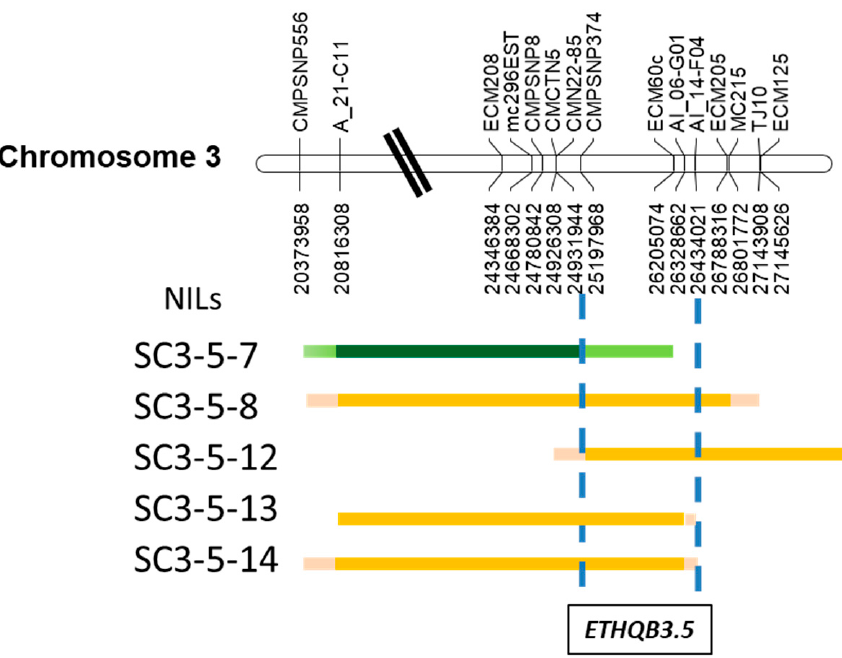
Figure 2. Ideogram showing the extent of the SC introgression on chromosome 3 among the Near- Isogenic Lines (NILs) and classification of their climacteric behavior (green—non-climacteric, orange— climacteric). Molecular markers are anchored to the melon genome v4.0. All the molecular markers are reported in Table S1. Pale or deep green color indicates introgressed region covered by non- climacteric NILs and pink–orange color by climacteric ones, according to Figures 3 and S1. Pink and light green indicate the regions between markers where the recombination occurred in each NIL.